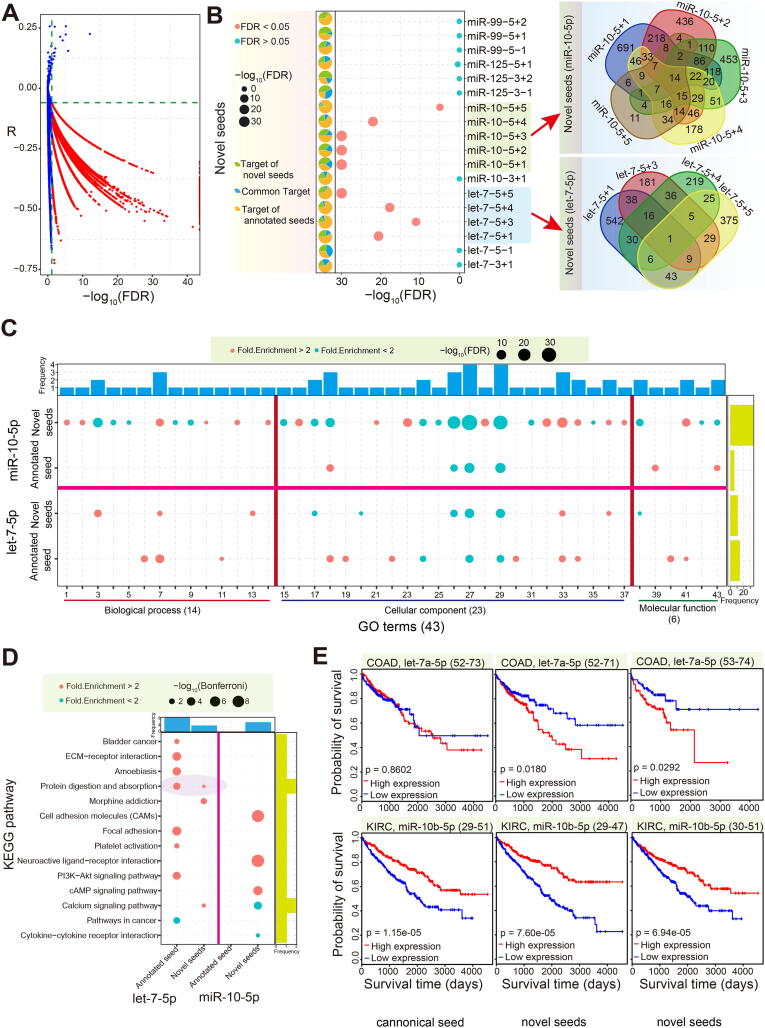
Target validation and analysis of function enrichment. (A) Correlation analysis of isomiRs and their targets. Interactions with a negative correlation (r < 0, FDR < 0.05) are selected for further analysis. (B) Distribution of potential differences between shifted seed sequences and annotated seeds as determined by hypergeometric distribution test, and Venn diagram showing detailed distributions among these novel seeds. (C) Bubble figure showing differences in enriched GO terms between annotated and novel seeds (FDR < 0.05). Biological process (1–14): 1, activation of phospholipase C activity; 2, axon guidance; 3, cell adhesion; 4, cell-cell signaling; 5, chemical synaptic transmission; 6, collagen catabolic process; 7, extracellular matrix organization; 8, homophilic cell adhesion via plasma membrane adhesion molecules; 9, nervous system development; 10, outflow tract morphogenesis; 11, platelet degranulation; 12, positive regulation of angiogenesis; 13, potassium ion transport; 14, smooth muscle contraction. Cellular component (15–37): 15, apical plasma membrane; 16, basolateral plasma membrane; 17, cell junction; 18, cell surface; 19, collagen trimer; 20, dendrite; 21, endocytic vesicle membrane; 22, endoplasmic reticulum lumen; 23, external side of plasma membrane; 24, extracellular region; 25, extracellular space; 26, integral component of membrane; 27, integral component of plasma membrane; 28, neuron projection; 29, plasma membrane; 30, platelet alpha granule lumen; 31, postsynaptic density; 32, postsynaptic membrane; 33, proteinaceous extracellular matrix; 34, receptor complex; 35, synapse; 36, voltage-gated potassium channel complex; 37, Z-disc. Molecular function (38–43): 38, calcium ion binding; 39, cholesterol binding; 40, extracellular matrix structural constituent; 41, heparin binding; 42, receptor activity; 43, transcriptional activator activity, RNA polymerase II core promoter proximal region sequence-specific binding. (D) Bubble figure showing differences in enriched KEGG pathways between annotated and novel seeds (Bonferroni, p < 0.05 and FDR < 0.2). (E) Survival analysis based on different isomiR types.